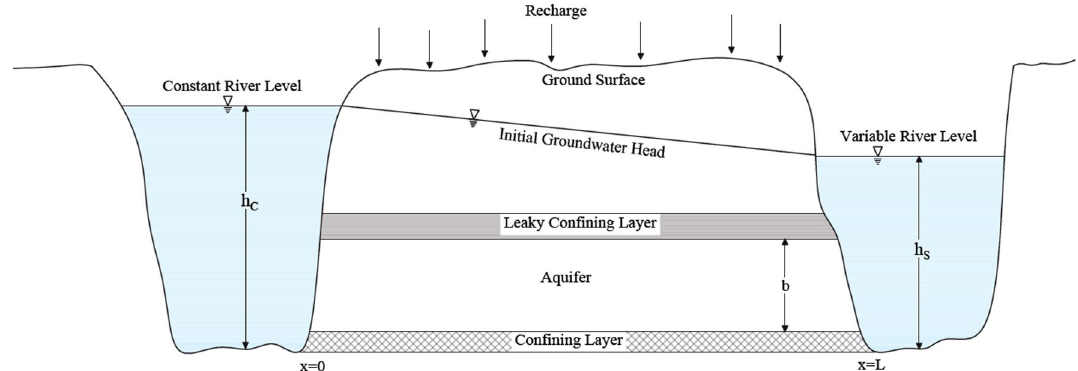
Fig. 1 Schematic of groundwater flow in a river-aquifer